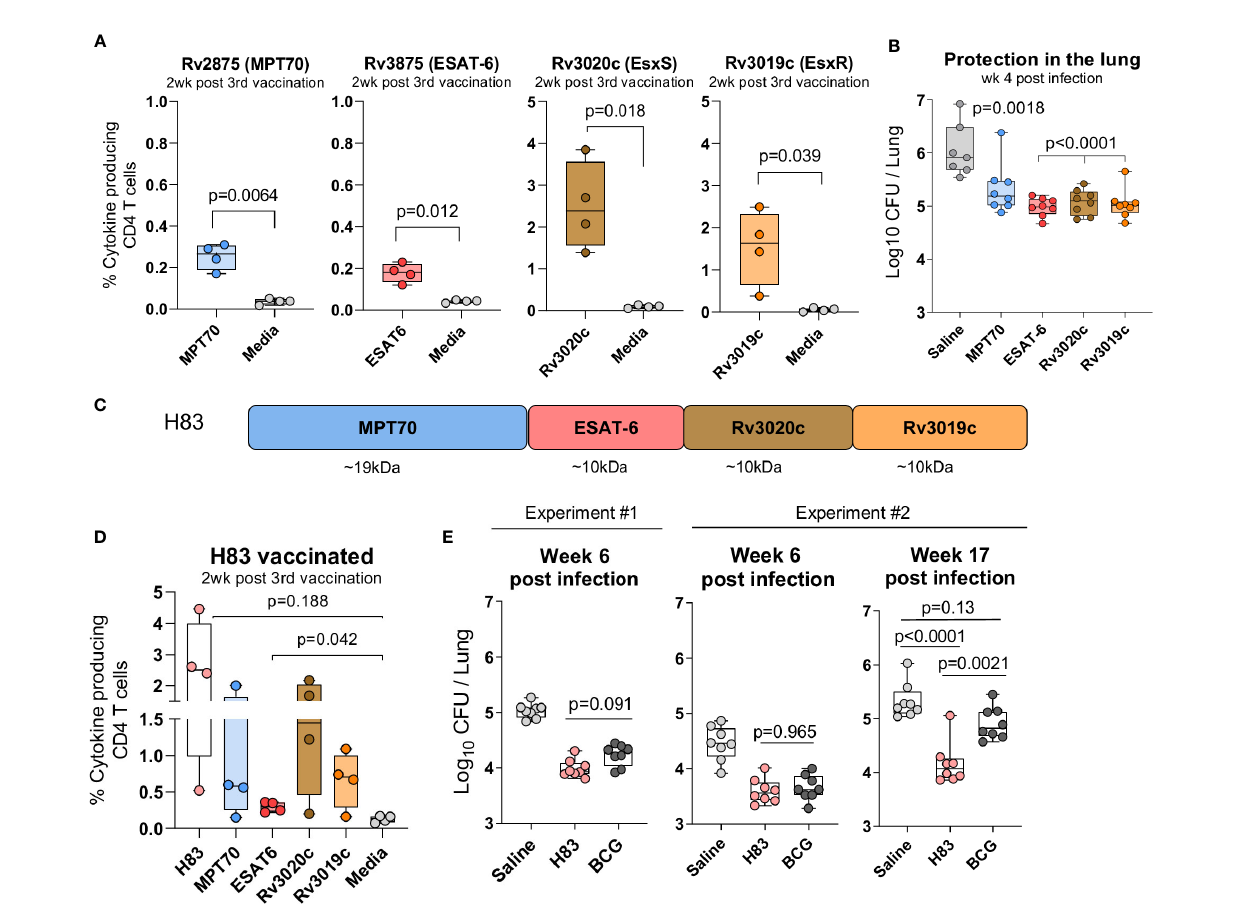
FIGURE 2 | H83, a fusion protein of immunodominant antigens, confer robust long-term protection. Female CB6F1 mice were vaccinated with 10 µg of either MPT70, ESAT-6, Rv3020c, Rv3019c, or Tris-HCL buffer three times s.c. at the base of the tail. (A) Immunogenicity of single antigens were assessed two weeks after 3 rd immunization by stimulating splenocytes in vitro with individual antigens or media. Figures represent percentage of cytokine producing (TNF a and/or IFN-y and/or IL-2) CD4 T cells after intracellular cytokine staining (ICS) (n = 4). The gating strategy for antigen-speci fi c CD4 T cells is shown in Supplementary Figure 1 . Paired t-test, two-tailed, t-values (6.84, 5.52, 4.71, 3.51, df = 3). (B) Vaccine-mediated protection were determined by counting the bacterial numbers in the lungs of MPT70-, ESAT-6-, Rv3020c-, and Rv3019c- vaccinated mice at week 4 post Mtb Erdman infection (n = 7 – 8). Colony forming units (CFUs) for one saline mouse was too numerus to count. One-way ANOVA with Tukey ’ s multiple comparison test, F-value (5, 41) = 41.59. (C) The fusion protein, hybrid 83 (H83), was composed of MPT70, ESAT-6, Rv3020c, and Rv3019c in the mentioned order. (D) Percentage of cytokine-producing CD4 T cells after H83 vaccination measured by ICS. Splenocytes were restimulated with H83, MPT70, ESAT-6, Rv3020c, Rv3019c, or media two weeks after 3 rd immunization (n = 4). Brown-Forsythe and Welch ANOVA tests with Dunnett ’ s multiple comparison test, F-value (5.000, 6.606) = 4.351, W-value (5.000, 7.664) =5.975. (E) CB6F1 mice were vaccinated with 2 µg H83 three times or once with 2x10 5 CFU BCG Danish. Six weeks after 3 rd subunit vaccination or ten weeks after BCG immunization, mice were challenged with Mtb. Bacterial numbers were determined in the lungs of H83- and BCG-vaccinated mice in two individual experiments at week 6 and one experiment at week 17 post Mtb infection (n = 8). One-way ANOVA with Tukey ’ s multiple comparison test was performed, and the exact p-values indicated, F-values (3, 28) = 44.02, 23.07, 21.26. Data shows box plots with whiskers indicating minimum and maximum